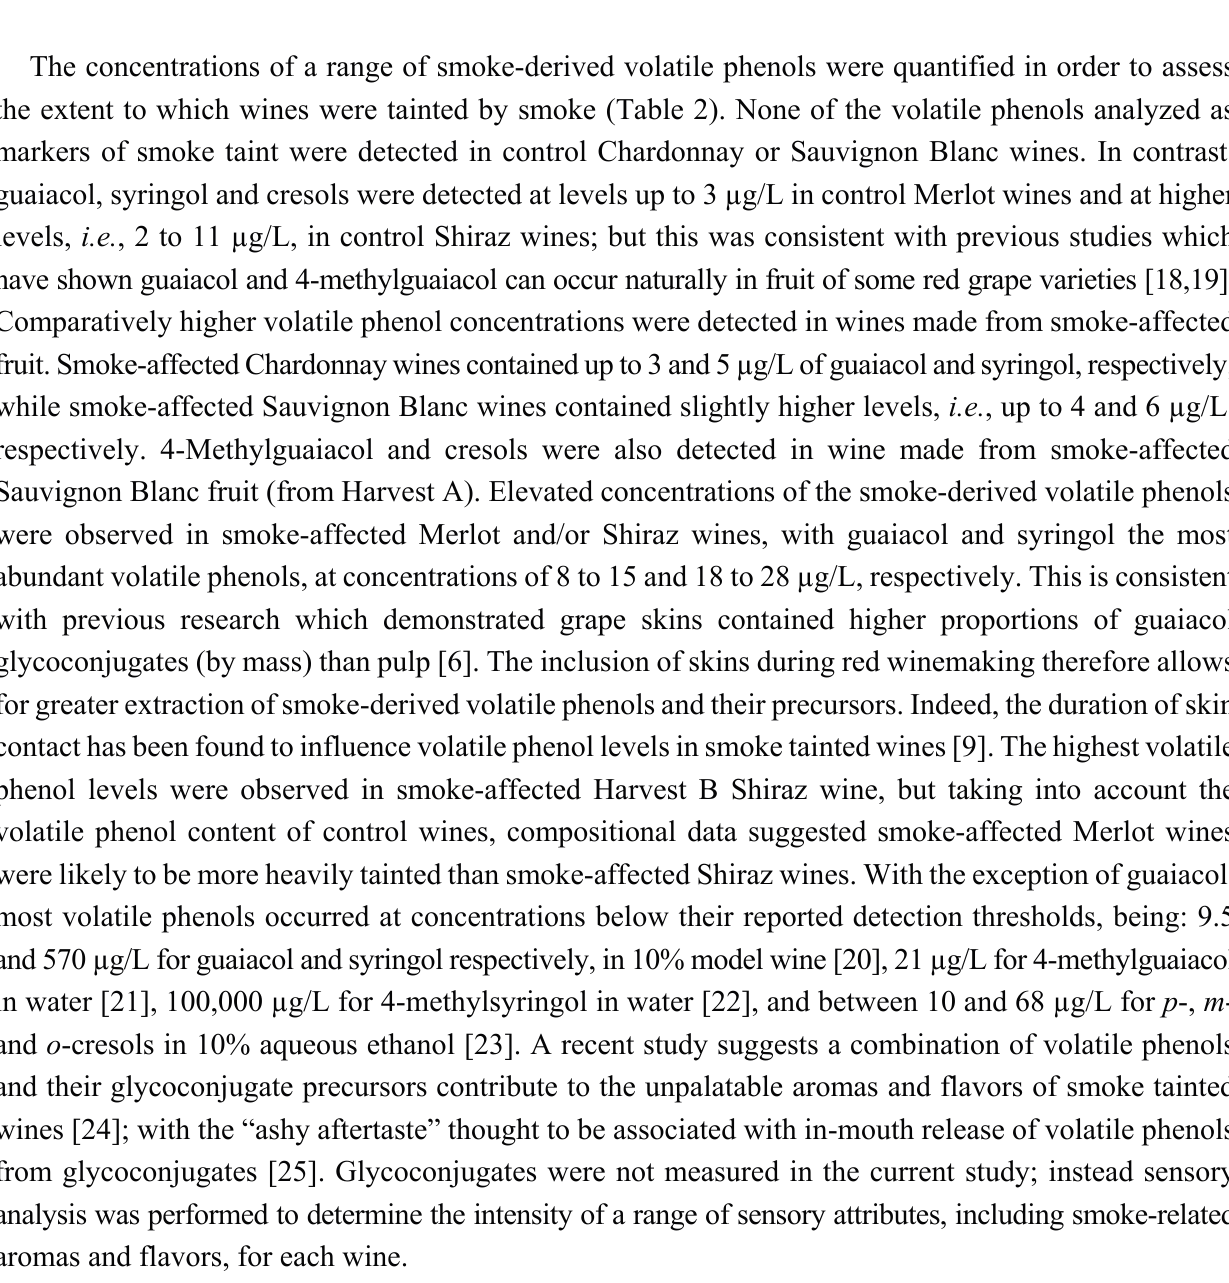
Table 2. Concentrations (µg/L) of smoke-derived volatile phenols in control and smoke-affected Chardonnay, Sauvignon Blanc, Merlot and Shiraz wines.